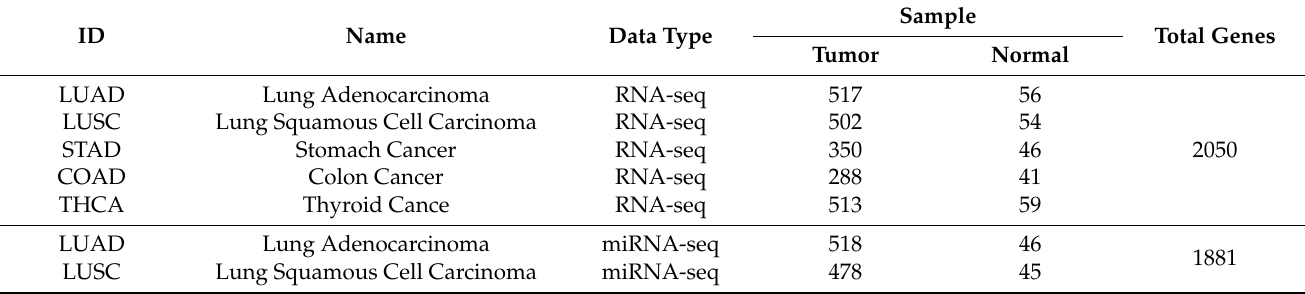
Table 1. Number of samples and genes in five types of